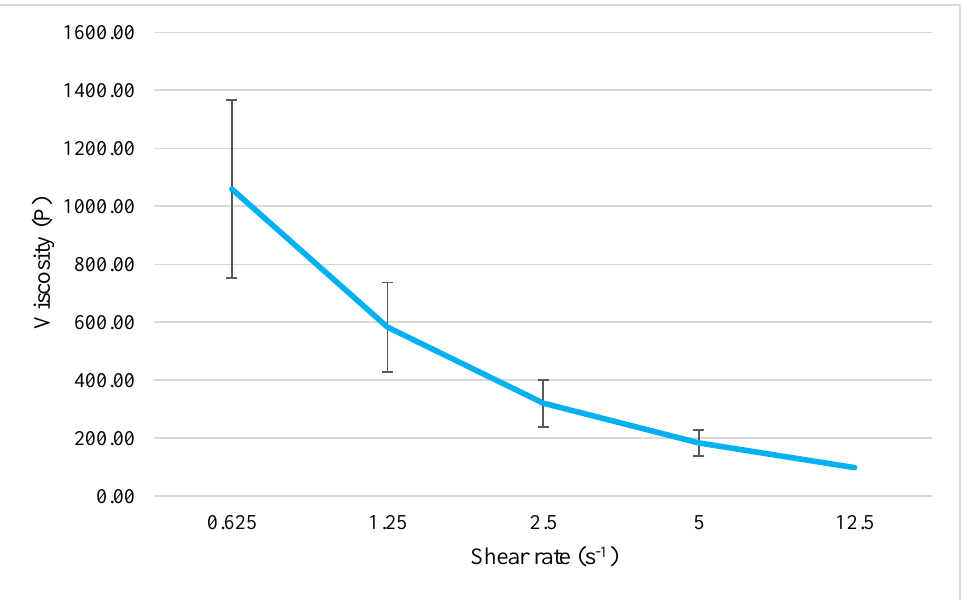
Figure 5. Influence of shear rate on viscosity of NIO-HAMIN F1 − C emulgel. Data presented as mean ± SD ( n = 3).